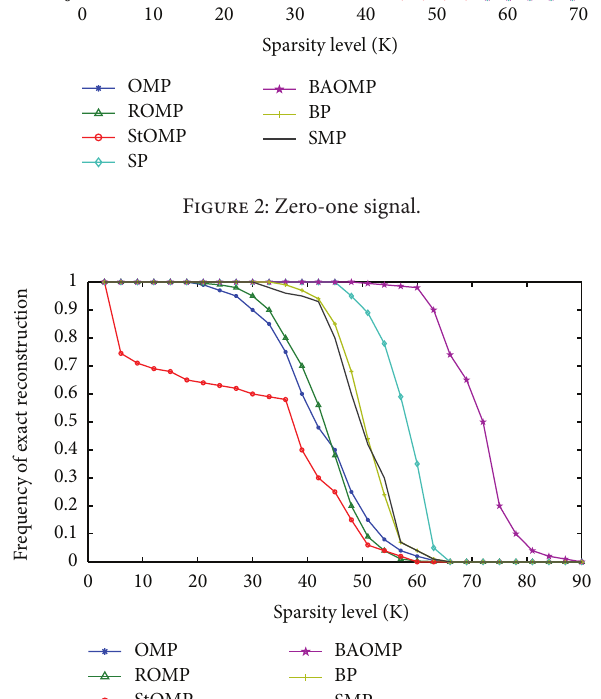
Figure 3: Gaussian